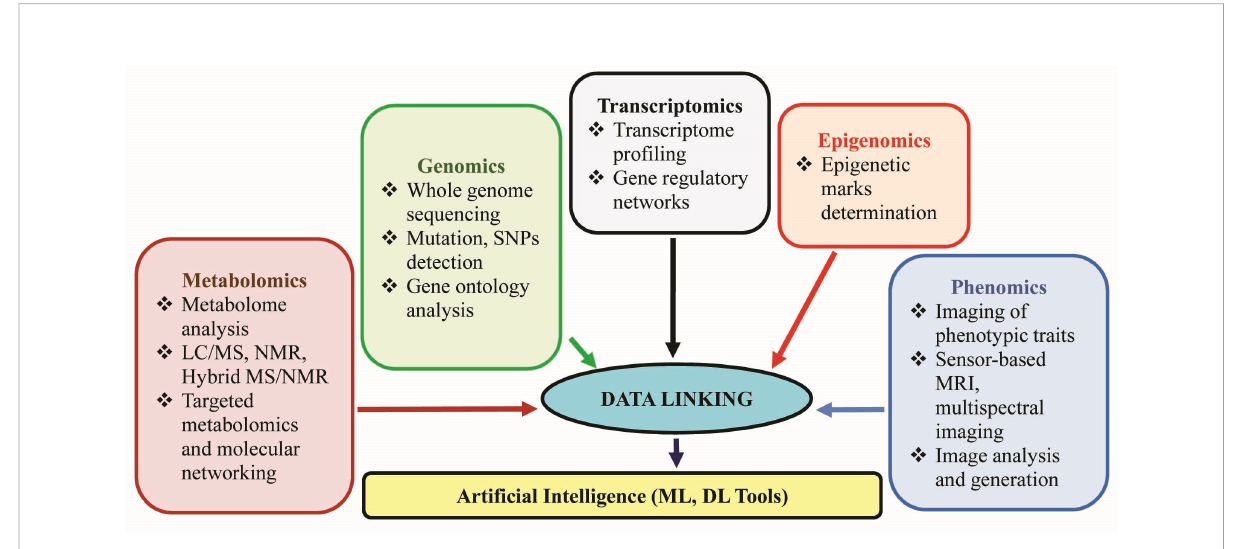
FIGURE 2 Multi – omics approach for understanding plant systems under stress and the role of